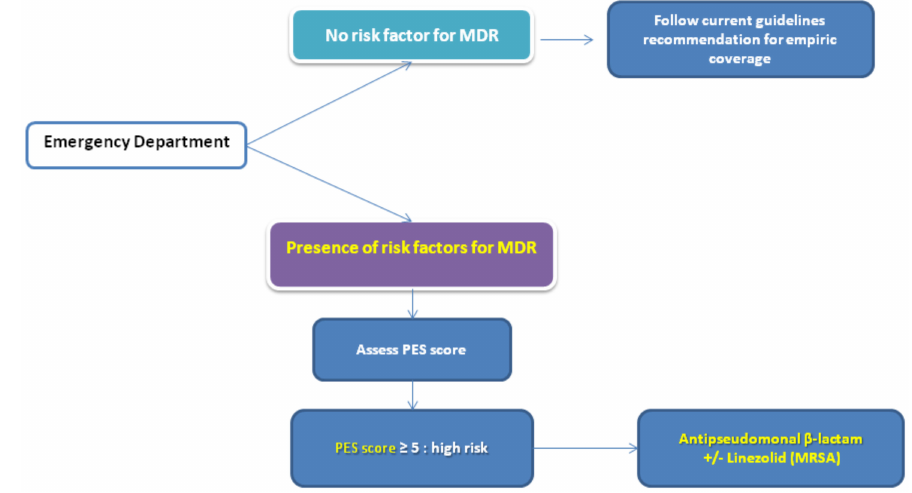
Figure 2. The management of severe community-acquired